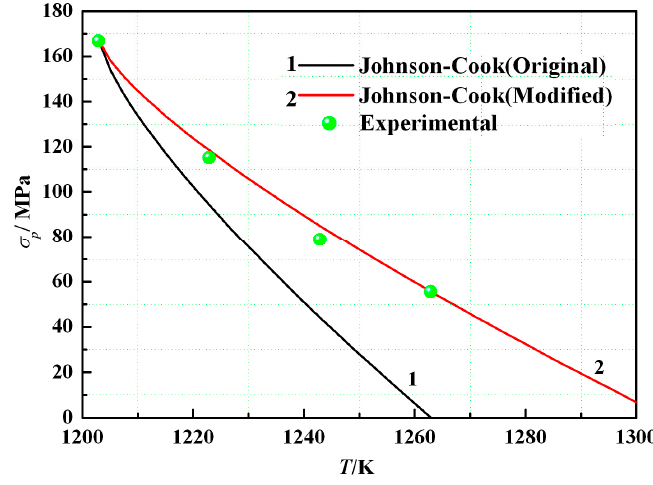
. ε = 1.0 × 10 − 3 s − 1 for the two J–C